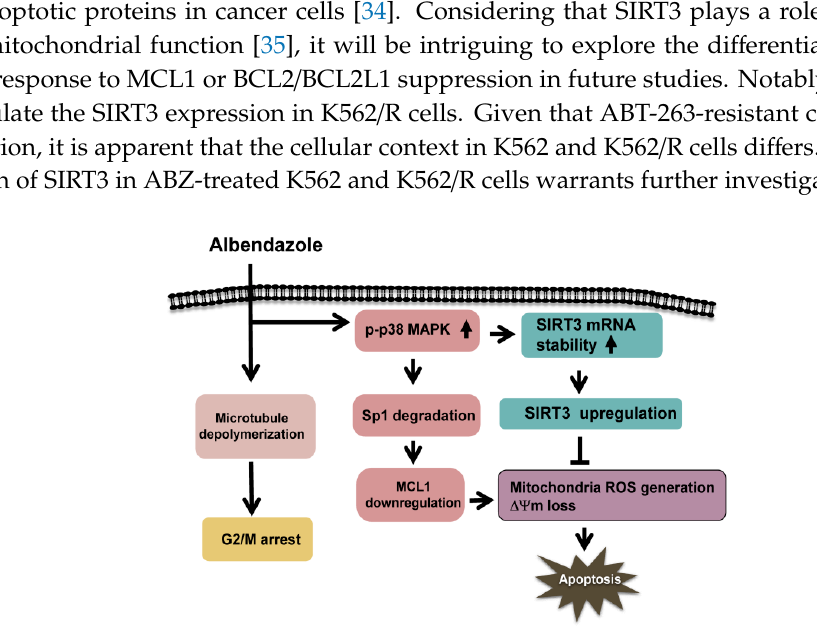
Figure 8. Signaling pathways elucidate the protective effect of SIRT3 upregulation on the cytotoxicity of ABZ-induced MCL1 suppression in K562 cells. ABZ treatment simultaneously induces microtubule depolymerization, MCL1 downregulation, and SIRT3 upregulation in K562 cells. ABZ inhibits MCL1 transcription through p38 MAPK-mediated Sp1 degradation. Meanwhile, ABZ-induced p38 MAPK activation increases the stability of SIRT3 mRNA and SIRT3 protein expression in K562 cells. SIRT3 upregulation delays ABZ-induced apoptosis in K562 cells when ABZ inhibits MCL1 expression. Thus, SIRT3 expression modulates the capability of ABZ to induce apoptosis in K562 cells.